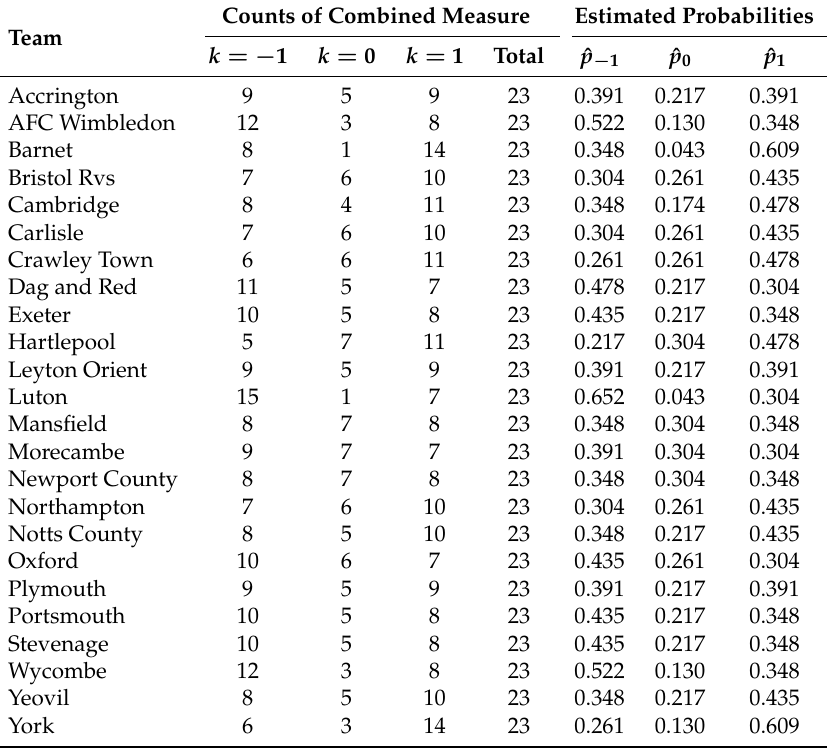
Table 9. Observed counts of combined measure for the 2015/2016 season of EN 4